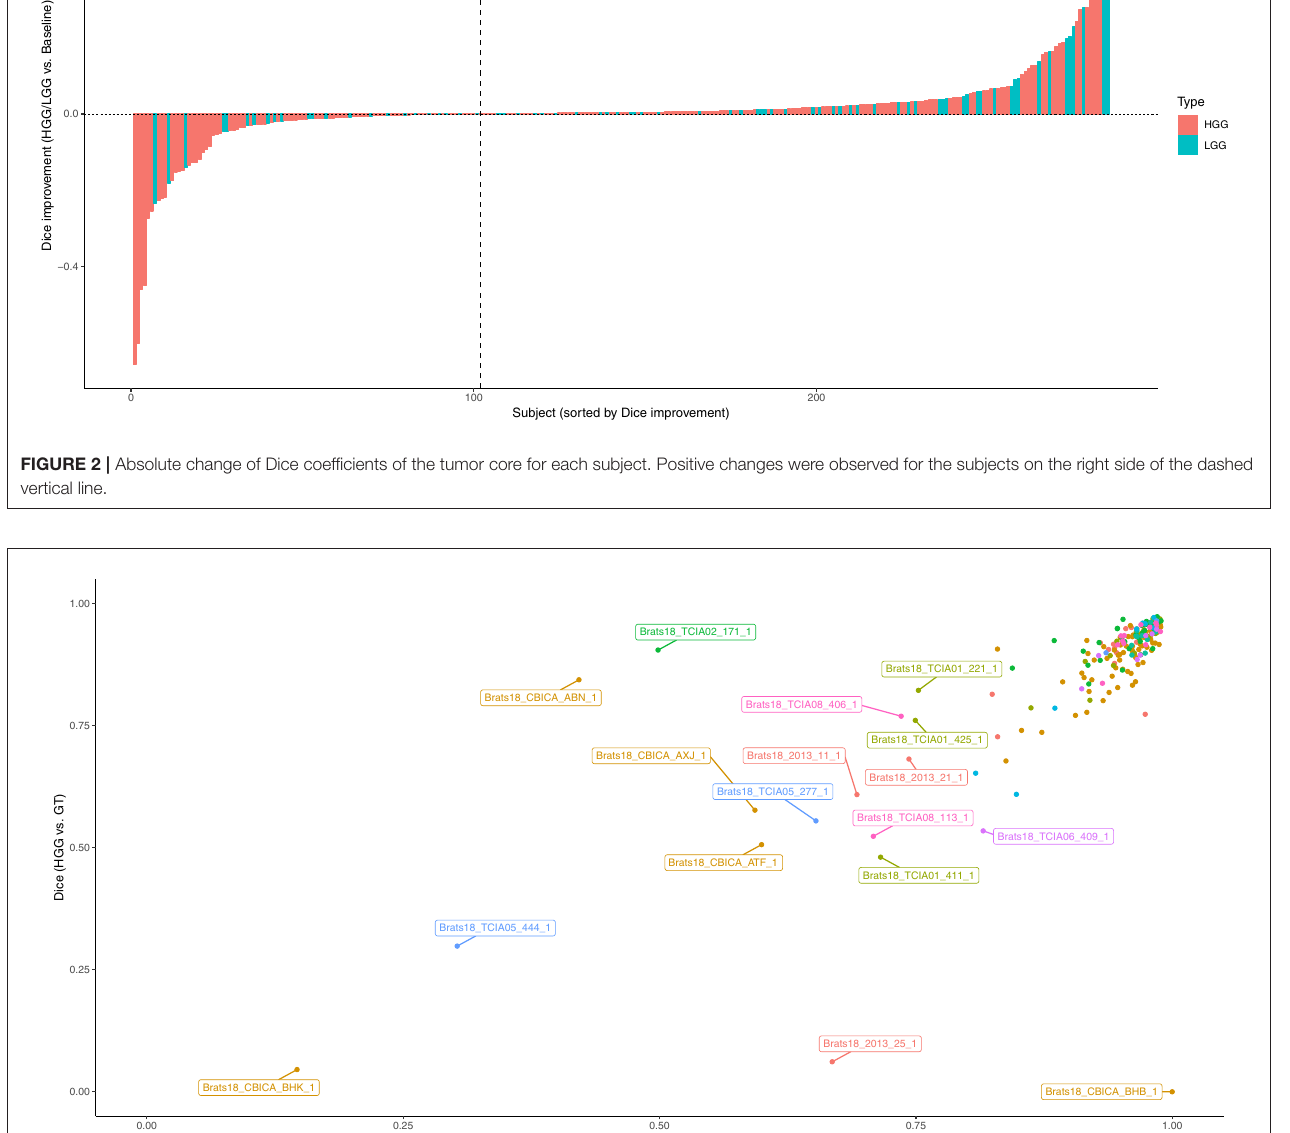
with a distortion of the gray/white matter junction. In contrast, edema would preserve the gray/white matter junction as well as the cortical ribbon and propagate along the white matter fiber tracts. A possible alternative for ground truth is shown in Figure 6